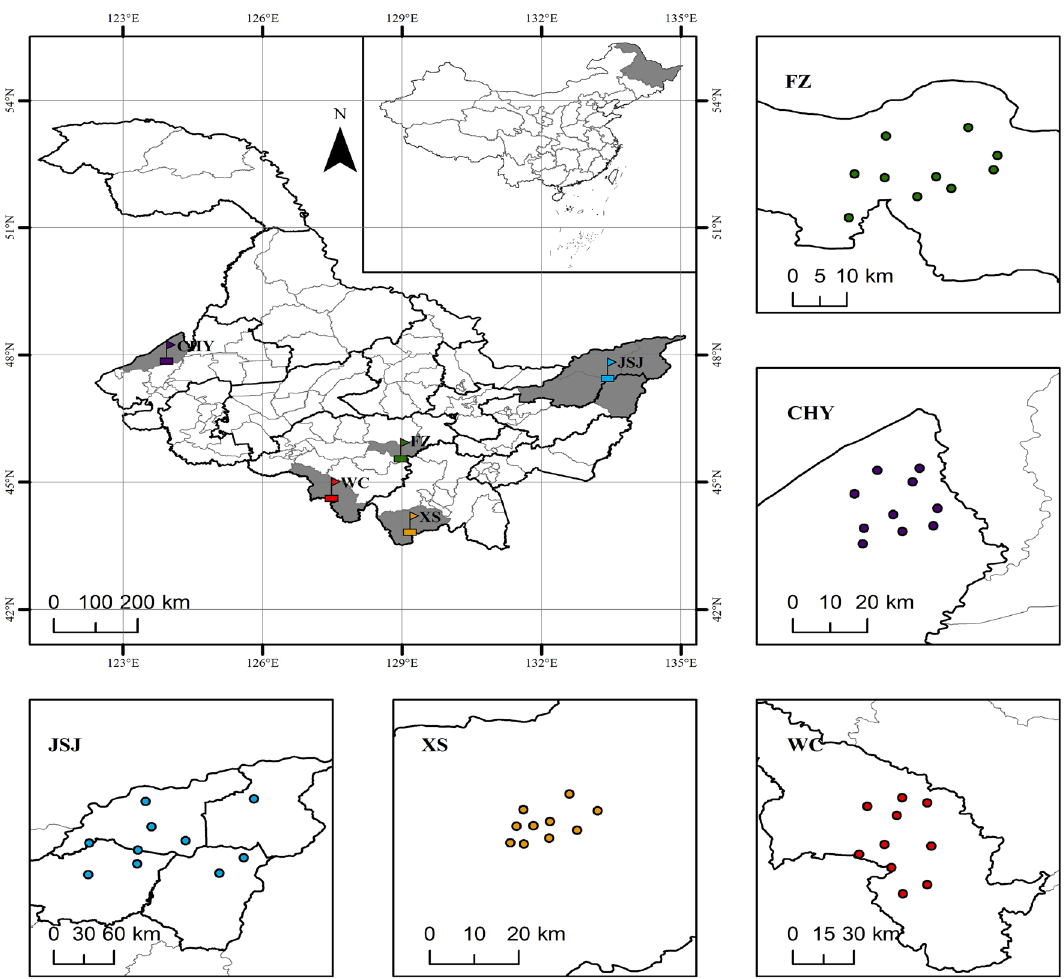
Figure 4. Distribution japonica sampling sites in Heilongjiang Province. The distribution map was generated by ArcGIS Pro software (https:// www. esri. com/ en- us/ arcgis/ produ cts/ arcgis- pro.) and was based on the latitude and longitude data measured at the sampling